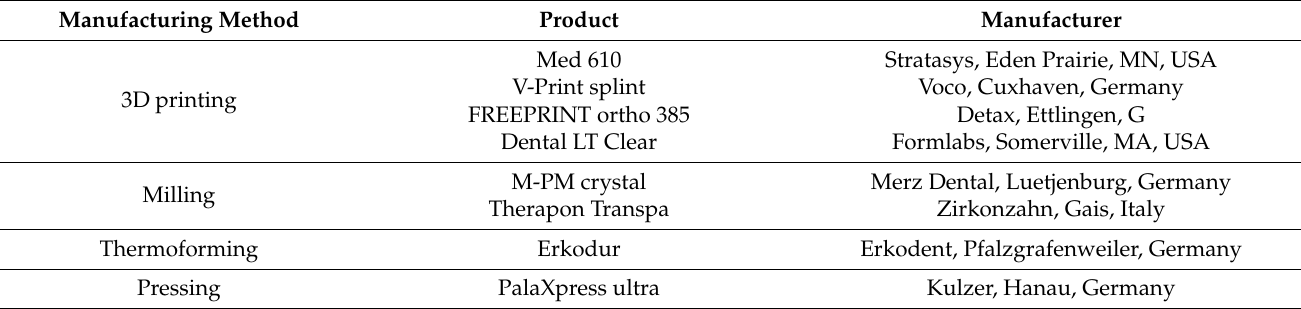
Table 1. Specification of the splint resins investigated in this